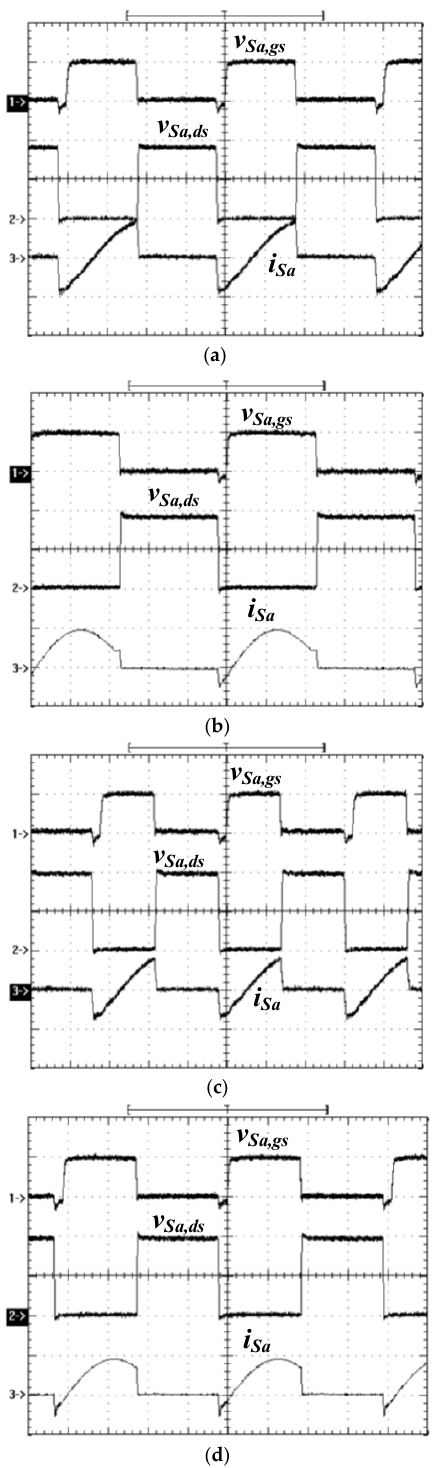
Figure 8. Experimental waveforms of v Sa,gs , v Sa,ds and i Sa under ( a ) 750 V input and 5% load ( v Sa,gs : 10 V/div; v Sa,ds : 200 V/div; i Sa : 2 A/div; time: 2 μ s), ( b ) 750 V input and 100% load ( v Sa,gs : 10 V/div; v Sa,ds : 200 V/div; i Sa : 5 A/div; time: 2 μ s), ( c ) 800 V input and 5% load ( v Sa,gs : 10 V/div; v Sa,ds : 200 V/div; i Sa : 2 A/div; time: 2 μ s) and ( d ) 800 V input and 100% load ( v Sa,gs : 10 V/div; v Sa,ds : 200 V/div; i Sa : 5 A/div; time: 2 μ s).